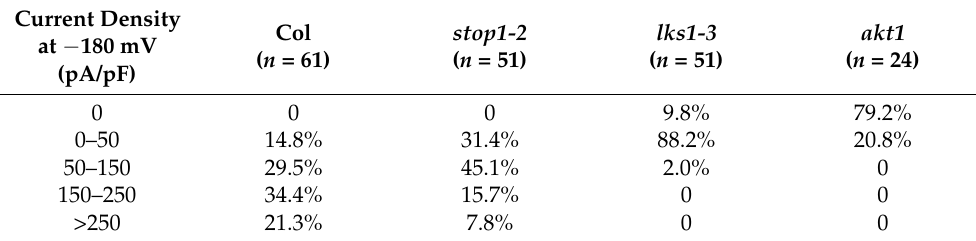
Figure 5. STOP1 binds to the LKS1 promoter in vivo. ( A ) Diagram of the LKS1 promoter and genomic region. Four fragments within the LKS1 promoter, P1 ( − 1506 to − 1366 bp), P2 ( − 974 to − 837 bp), P3 ( − 560 to − 441 bp), and P4 ( − 200 to − 51 bp), were used in ChIP-qPCR assay. The fragment G1 (1223 to 1357 bp) was used as a negative control. ( B ) ChIP-qPCR analyses of STOP1 binding activity to the LKS1 promoter. The roots of 12 day old seedlings ( pSuper:STOP1-MYC and Col) were harvested for ChIP assay using anti-MYC antibody. Then, the precipitated DNA was analyzed by qPCR assay. Data are means ± SE ( n = 3). ( C ) EMSA analyses showing the DNA-binding activity of STOP1 to the P3 fragment within LKS1 promoter. The purified His-STOP1 proteins were incubated with P3 probes labeled with biotin. Excessive unlabeled P3 probes (P3 Cold-probe) were added to compete with biotin-labeled probes. The mutant probes of P3 (M1 to M4) were shown in ( G ). ( D ) Yeast-one-hybrid analyses of STOP1 H266Y binding activity to the P3 fragment. STOP1 H266Y is the point mutation of STOP1 in the stop1-1 mutant. ( E ) The core binding sequence in the P3 fragment. The MEME online software was used to predict core binding sequence. ( F ) Yeast-one-hybrid assays showing that STOP1 could not bind to the mutated fragments of P3 (M1 to M4). ( G ) Four mutated fragments of P3 (M1 to M4) in the binding sequence. The core binding sequence was shown in red. Table 1. Statistical analysis of K + currents recorded in the root cell